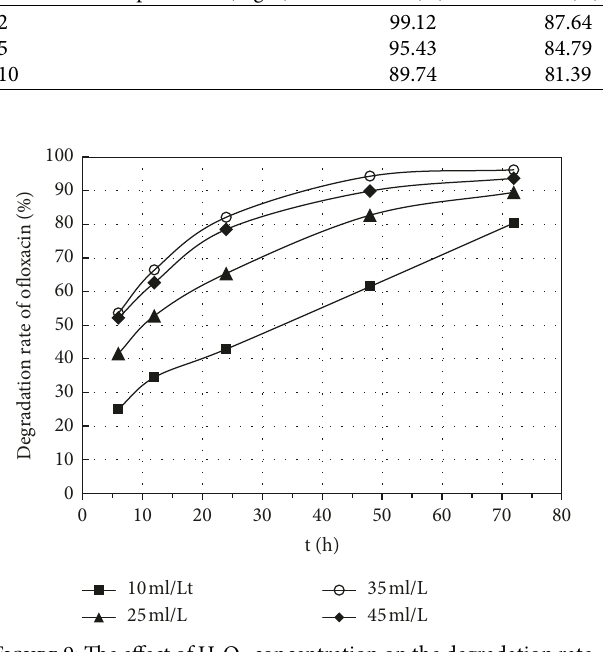
3 O 4 dosages on the degradation